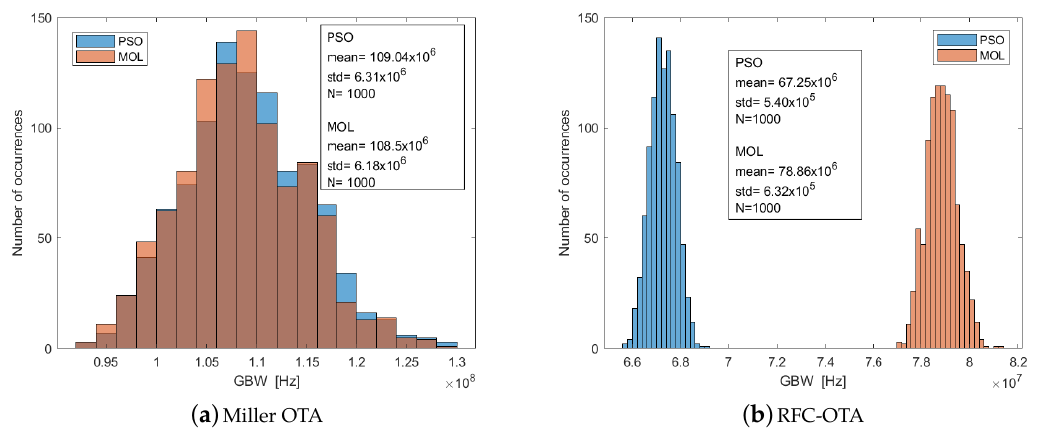
Figure 8. Monte Carlo simulations of the best